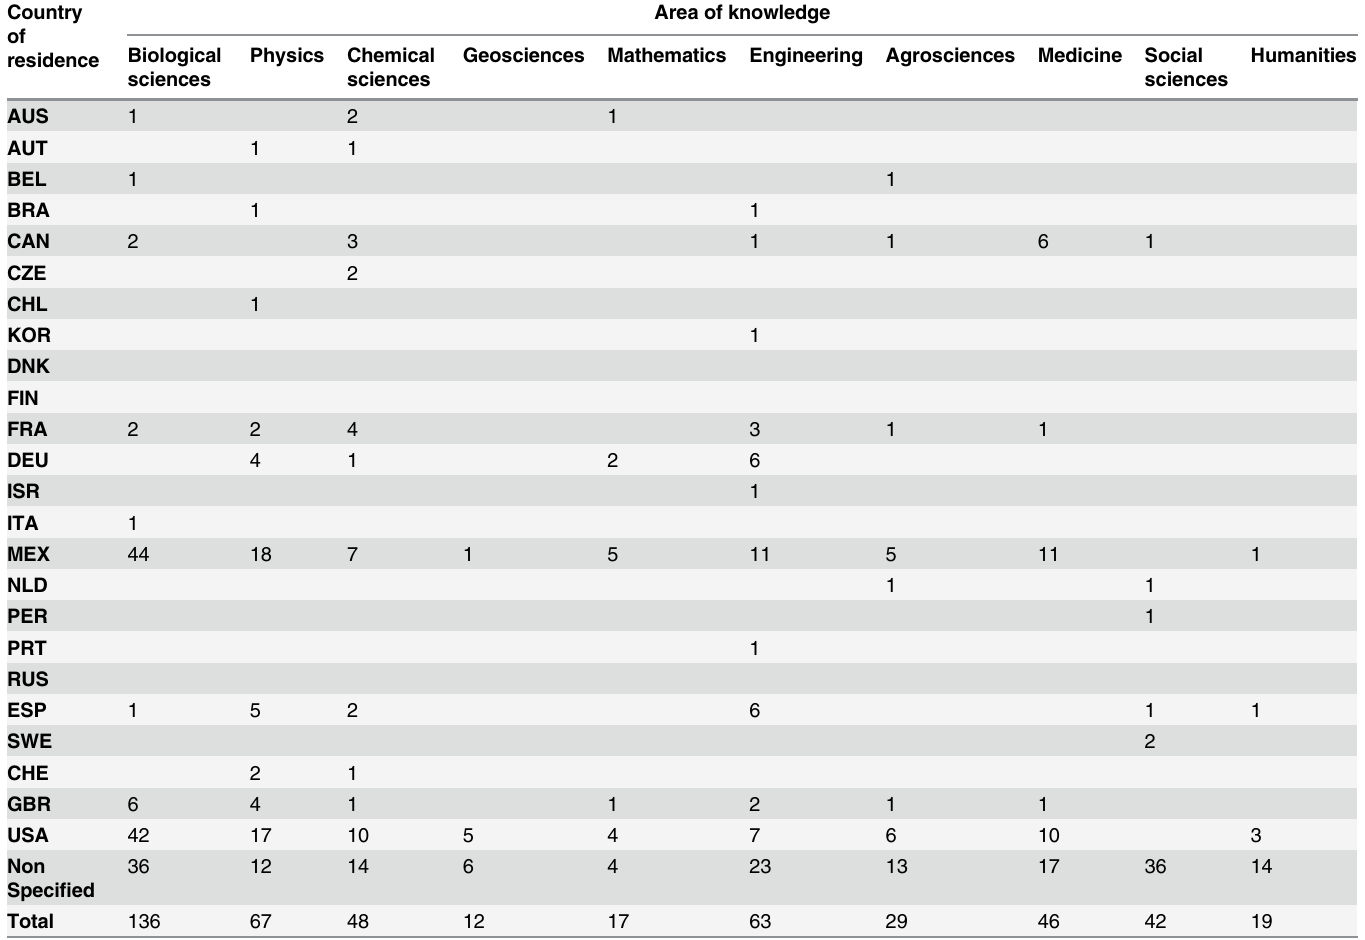
Table 3. Distribution of the number of researchers in the scientific Mexican Diaspora by present country of residence vs. area of knowledge